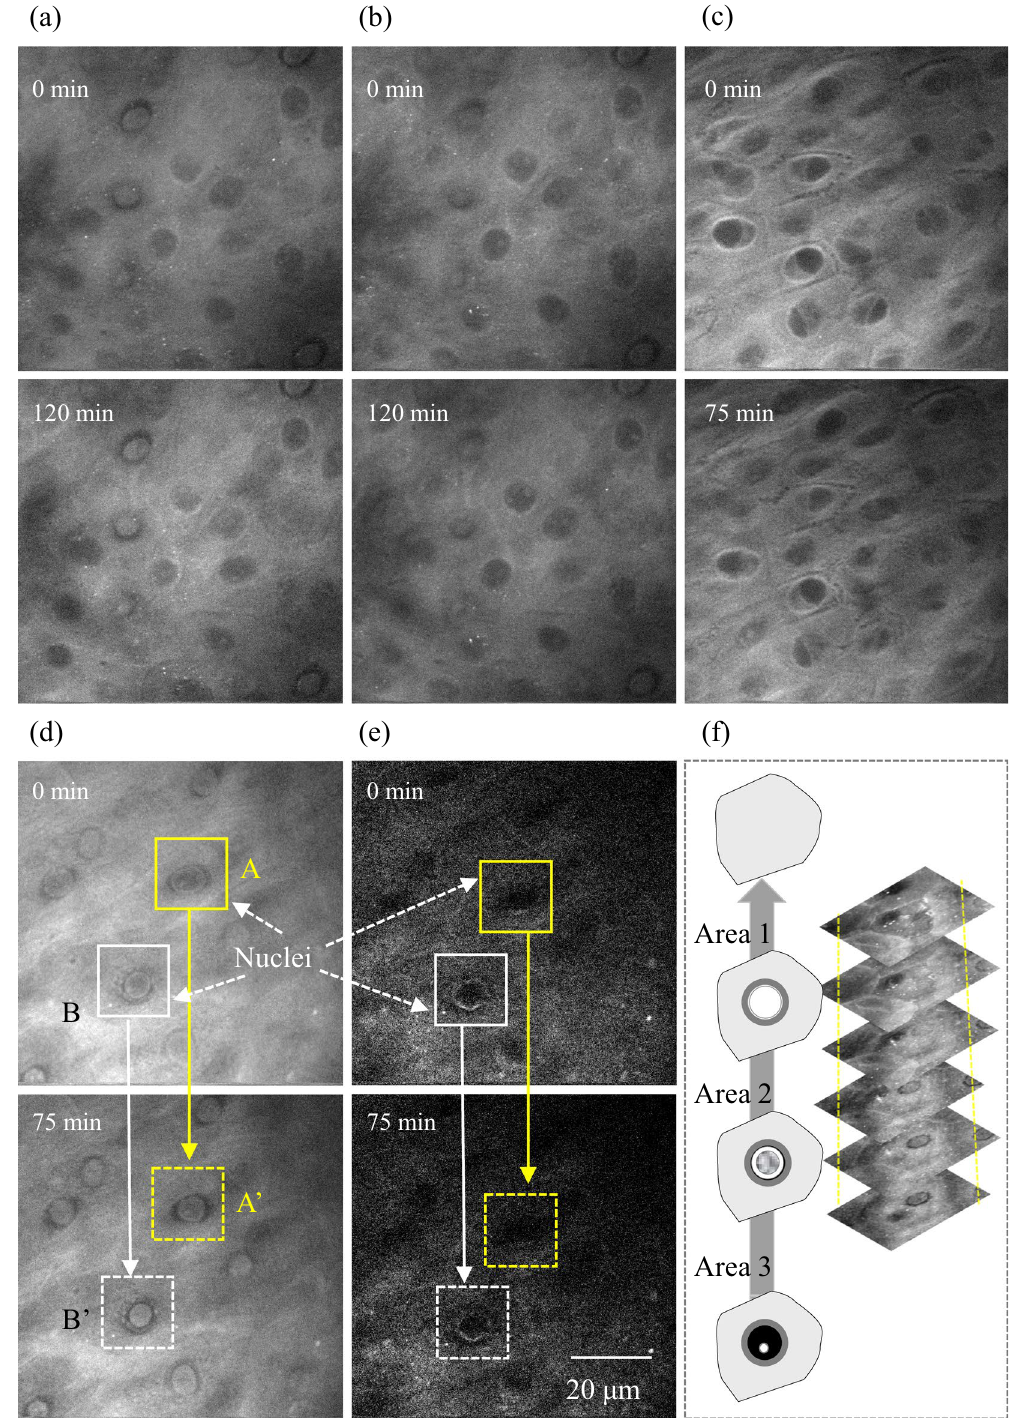
Figure 4. Typical time-lapse optical horizontal cross-section images in the stratum spinosum in abdominal skin of 39 and 49-year-old subjects. ( a ) 2930 cm − 1 of skin of a 39-year-old subject (corresponding to Areas 1 and 2), ( b ) 1 µ m lower part of ( a ) (corresponding to Areas 2 and 3), ( c ) 2930 cm − 1 of skin of a 49-year-old subject (corresponding to Area 3), ( d ) 2930 cm − 1 , and ( e ) 2850 cm − 1 of skin of a 49-year-old subject (corresponding to Areas 1 and 2). Time-lapse images were obtained without any treatment of the tissues. Regions A, B to A’, B’ show time-dependent changes in intracellular and nuclear morphology. The diagram in ( f ) shows suggested changes in nuclei during the enucleation process and optical cross-section images at 2930 cm − 1 at a near depth of ( d